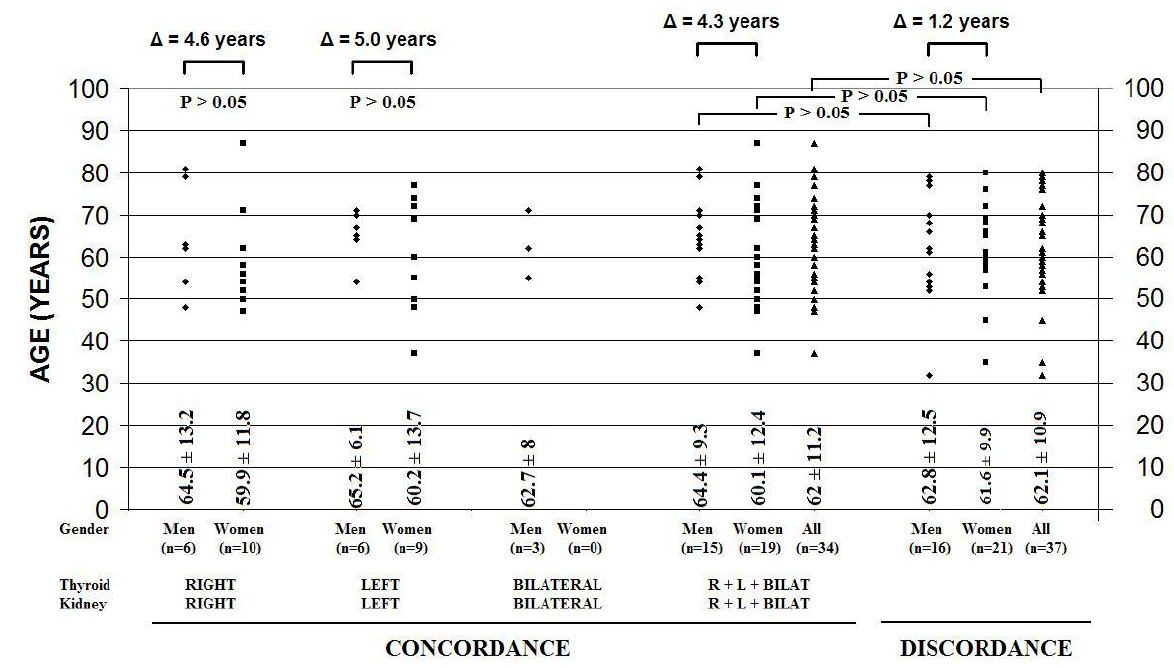
FIGURE 1. Age at presentation in patients stratified based on concordance of lateralization between the primary kidney cancer and the thyroid